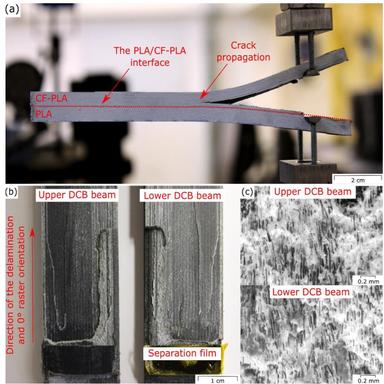
Delamination in the CF-PLA part of an unbalanced DCB sample (a), the fracture between the beams (b), and corresponding micrographs (c).